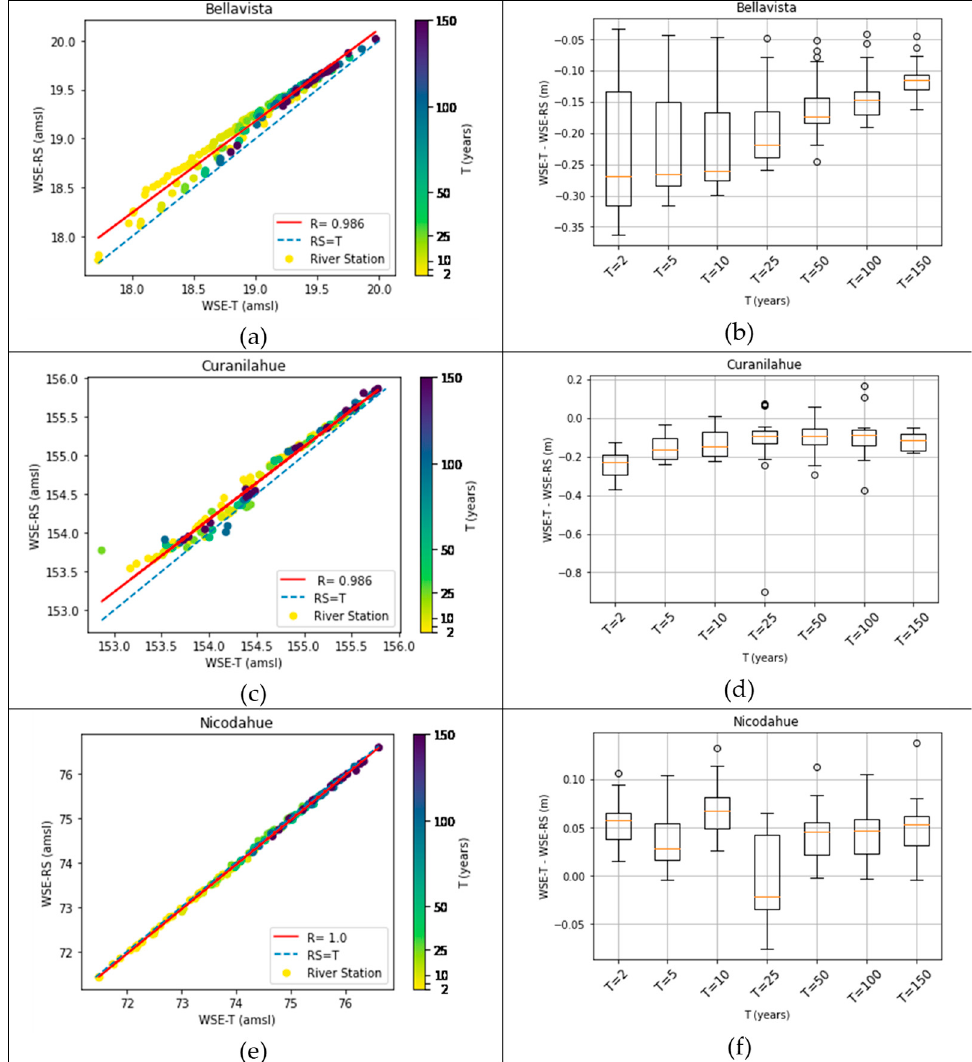
Figure 4. WSE-RS vs. WSE-T results for each cross section of the ( a ) Bellavista, ( c ) Curanilahue, and ( e ) Nicodahue rivers for different return periods. The dashed blue line shows the 1:1 ratio of WSE-T to WSR-RS and the red line shows the trend of the results and correlation (R). ( b , d , f ) show the distribution of differences between WSE-T and WSE-RS for the Bellavista, Curanilahue, and Nicodahue rivers, respectively.